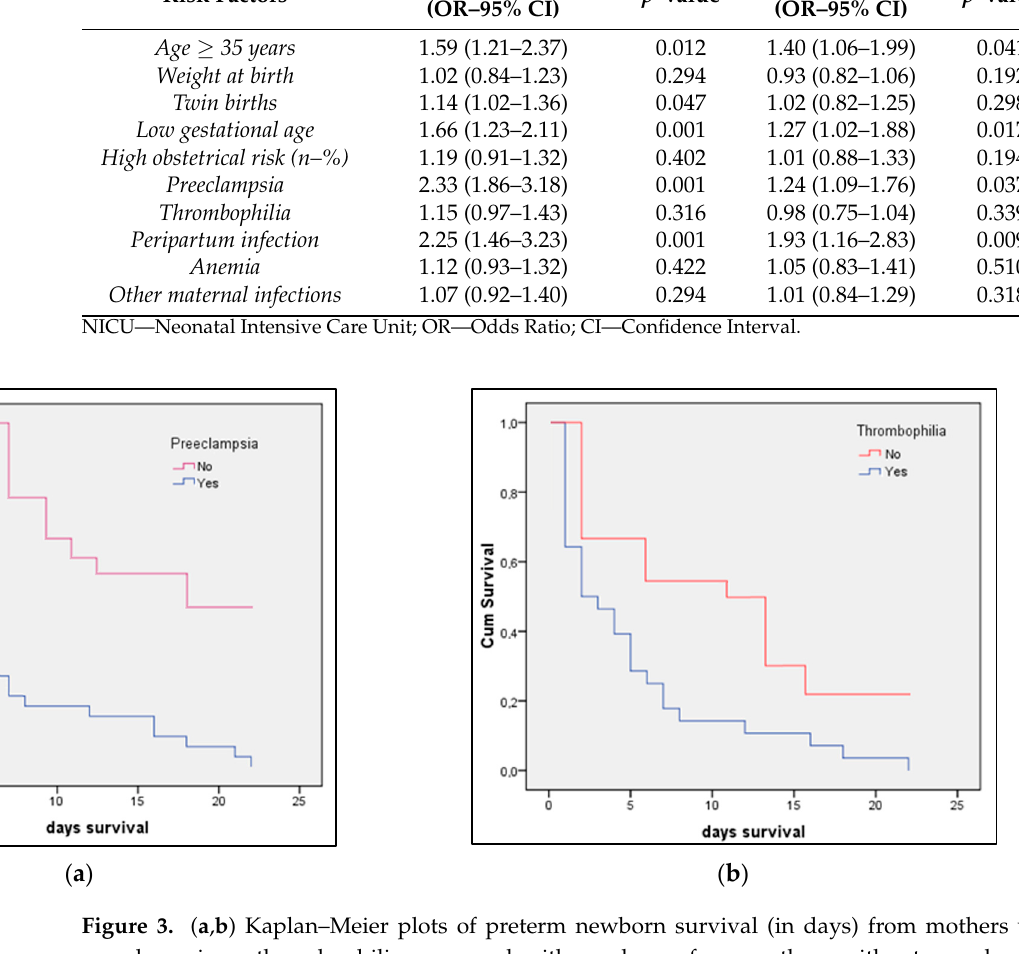
( b ) Figure 4. ( a , b ) Kaplan–Meier plots of preterm newborn survival (in days) from mothers with anemia or peripartum infections compared with newborns from mothers without anemia or peripartum infections. Figure 5. Kaplan–Meier plot of preterm newborn survival (in days)—4-year comparison.